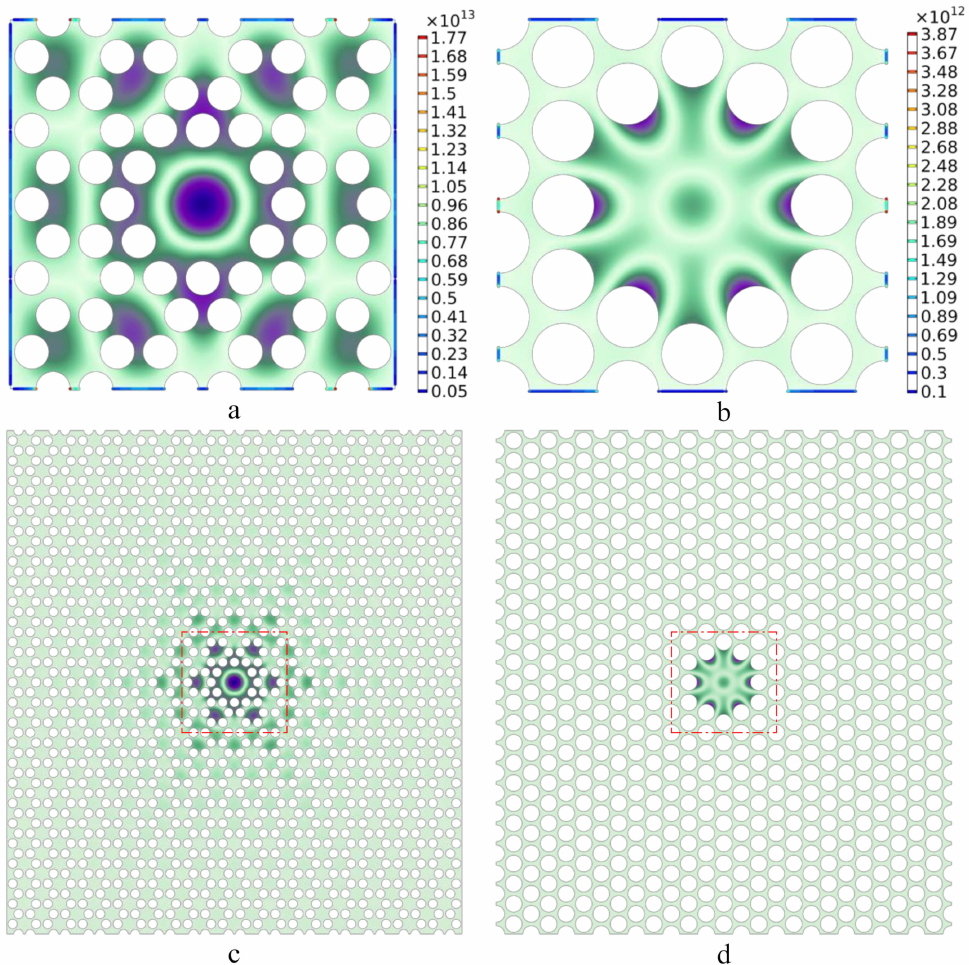
Figure 6. ( a , b ) The AuroraBorealis color (green and purple) depicts the first defect mode shape of the minimal cell-number structure with central defect in the hexagonal lattice and triangular lattice. The Rainbow color (blue and red) describes the normalized curvature in the fixed boundary area, with the legend on the right panel; ( c , d ) the first defect mode shapes of the 13 × 25-cell structure with central defect in the hexagonal lattice and triangular lattice. The region enclosed by the red dotted line frame is in the same geometry and size with ( a , b ),